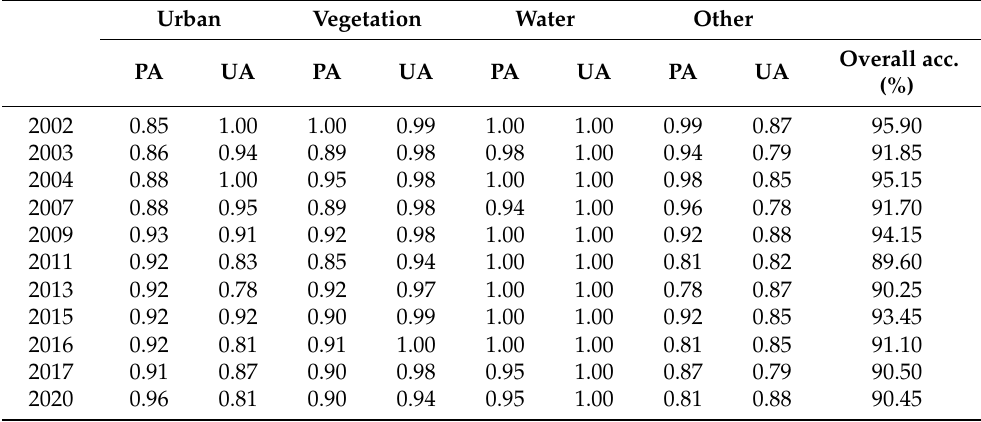
Table 3. The obtained producer’s accuracy (PA), user’s accuracy (UA), and overall accuracy values for the years 2002, 2003, 2004, 2007, 2009, 2011, 2013, 2015, 2016, 2017 and